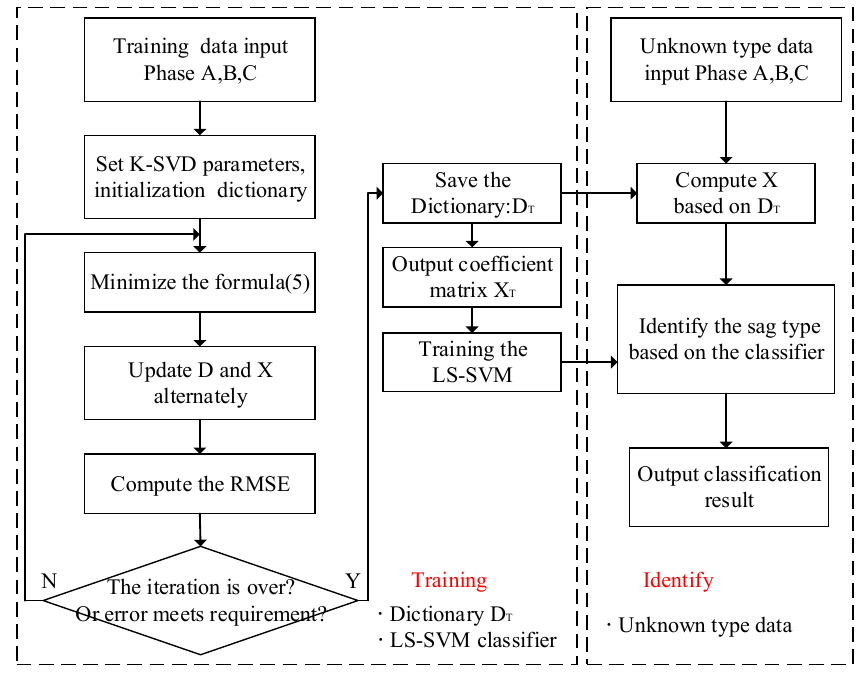
Figure 5. Algorithm flowchart.